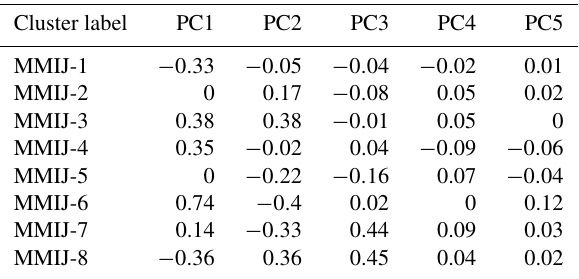
Table 2. Principal component coordinates of the cluster centroids for the filtered offshore dataset. The centroid positions in the PC1, PC2 space are depicted in Fig. 7a with the numbered